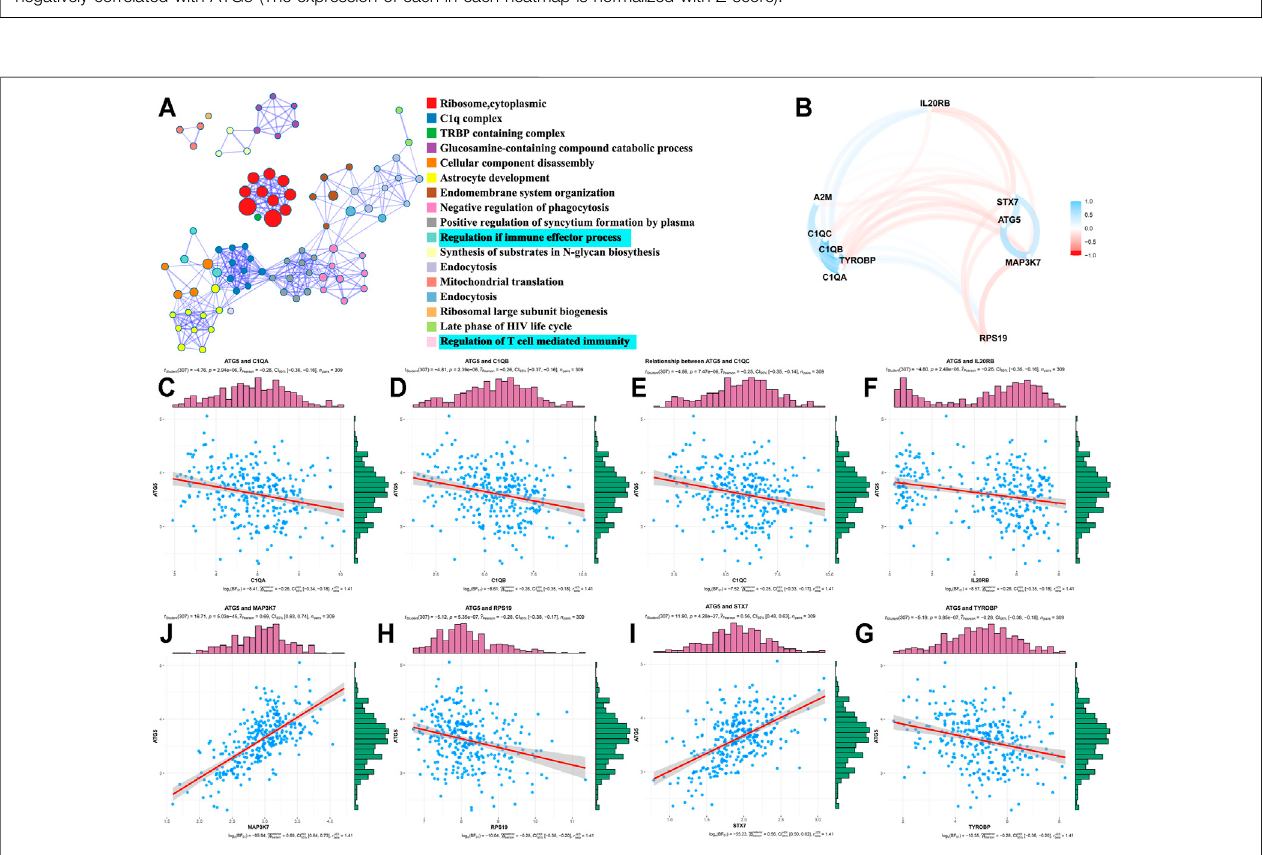
FIGURE 4 | GO analysis and correlation analysis (A) GO analysis revealed the biological processes and molecular functions involved in the top 100 ATG5-related co-expressed genes by “ metascape ” data (B) The correlation between ATG5 and co-expressed genes involved in the regulation of the immune effector process in cervicalcancerpatients.Bluelinesrepresentasnegatively correlatedgenes,while redlines represent aspositivelycorrelatedgenes (C-J) Amongthoseregulationofthe immune effector process genes, ATG5 expression was signi fi cantly negatively correlated with MAP3K7, STX7 and signi fi cantly positively related to A2M, C1QA, C1QB, C1QC, RPS19, TYROBP, and